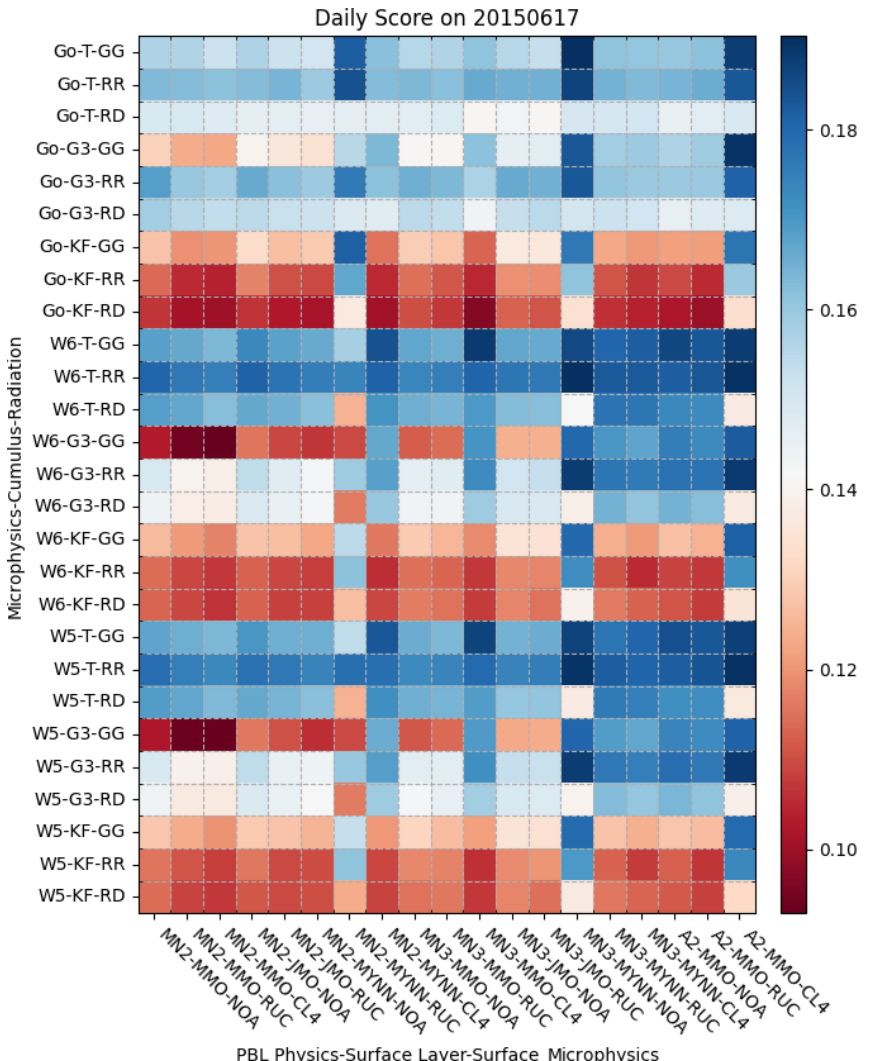
Figure 13. The heat map of the average κ for the configuration for the clusters of microphysics, cumulus parameterization, and the radiation physics ( y axis) with the cluster of PBL physics, surface physics, and the land surface model ( x axis) for the simulation case on 17 June for Set 2. The data only use the last 36h of simulations for calculating κ